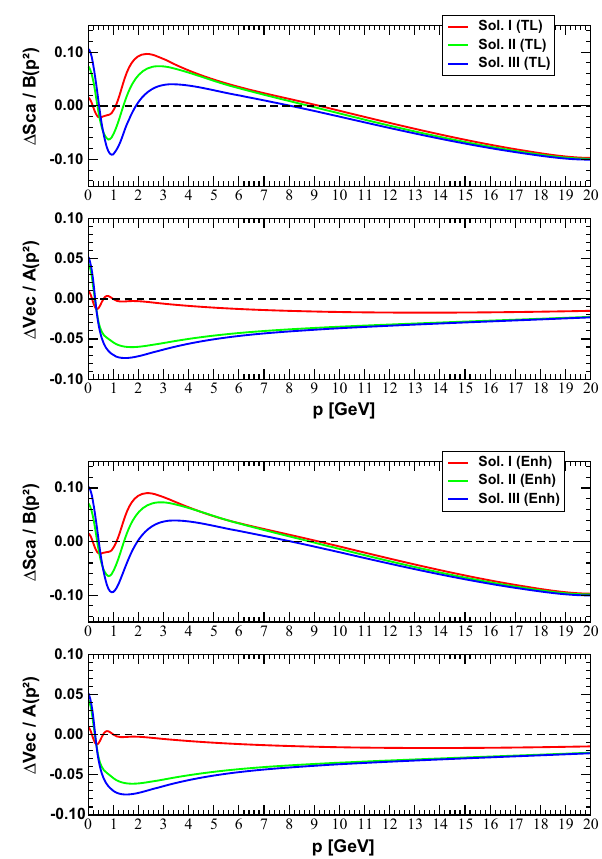
Fig. 14 Scalar (top) and Vector (bottom) Dyson–Schwinger equations and the differences between its lhs and rhs when using the tree level ghost-gluon vertex (top) and the enhanced gluon-ghost vertex (bottom)